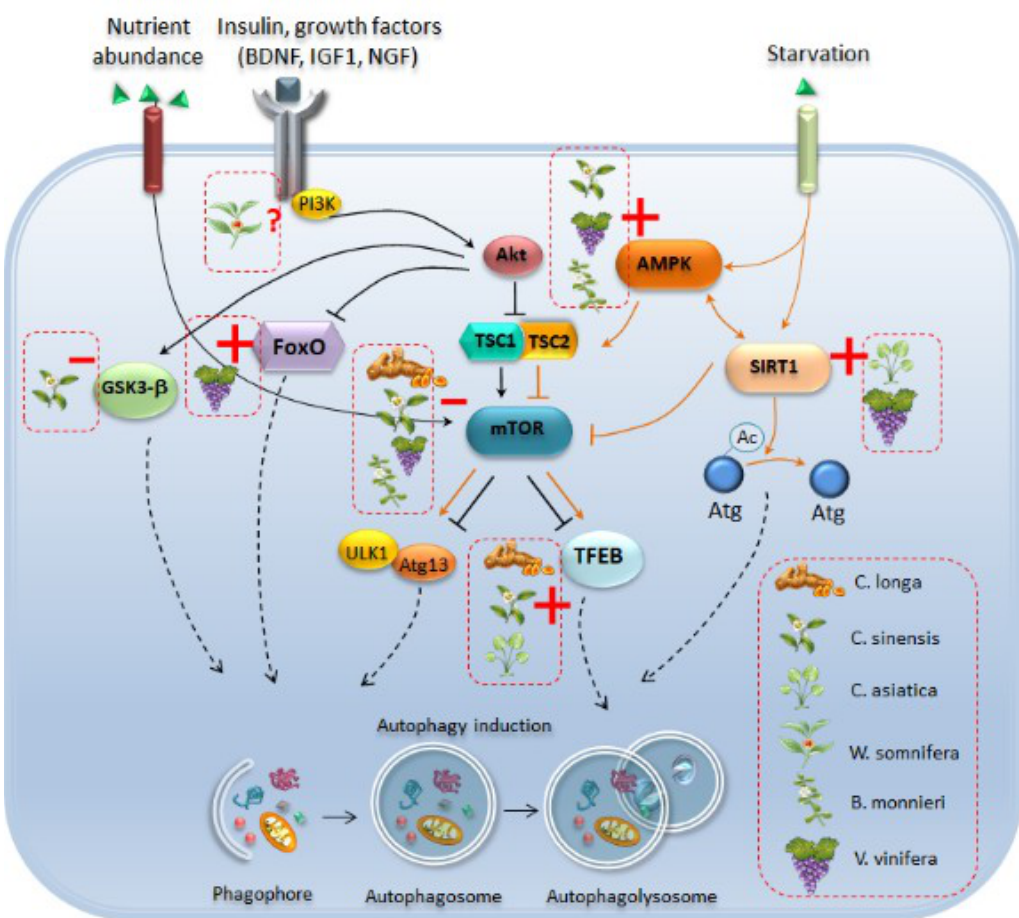
Figure 3. Autophagy-related molecular pathways which are targeted by phytochemical-rich plants. Phytochemicals induce autophagy by acting at several molecular levels. Curcumin ( C. longa ), catechins of green tea ( C. sinensis ), resveratrol ( V. vinifera ) and bacosides ( B. monnieri ) act as mTOR inhibitors, which leads to autophagy induction either through activation of ULK1 / Atg13 or transcription factor EB (TFEB). In particular, curcumin, green tea catechins, and C. asiatica activate TFEB to promote its translocation to the nucleus, and the subsequent induction of autophagy-related genes. Catechins of green tea and withanolides from W. somnifera may also activate autophagy through inhibition of Glycogen Synthase Kinase 3 Beta (GSK-3 β ), while resveratrol fosters the activation of the autophagy-promoting transcription factor FoxO3. Again, green tea catechins, resveratrol and B. monnieri activate autophagy through enhancement of AMP-activated Protein Kinase (AMPK), which in turn is an upstream inhibitor of mTOR and an activator of Sirtuin-1 (SIRT1). Activation of SIRT1-dependent autophagy through deacetylation of Atg proteins is mainly induced by resveratrol and C. asiatica . Again, W. somnifera may also act upstream of autophagy by modulating the IGF1-Akt axis, although a role has not been confirmed yet. Plain black arrows indicate pathways which act as upstream inhibitors of autophagy while plain orange arrows indicate pathways which promote autophagy. Dashed black arrows indicate pathways converging towards autophagy machinery. Red dashed boxes indicate the specific phytochemicals which activate autophagy by acting as inhibitors (red line) or inducers (red cross) of specific autophagy­related molecules.